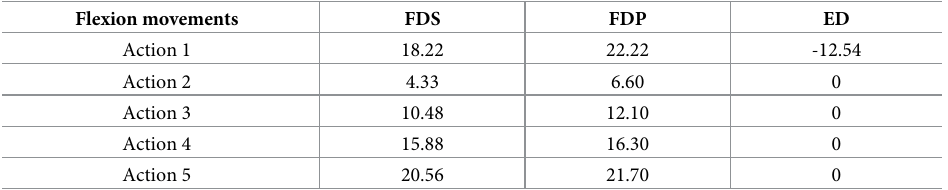
Table 2. MTJ displacements of each muscle during flexion movements